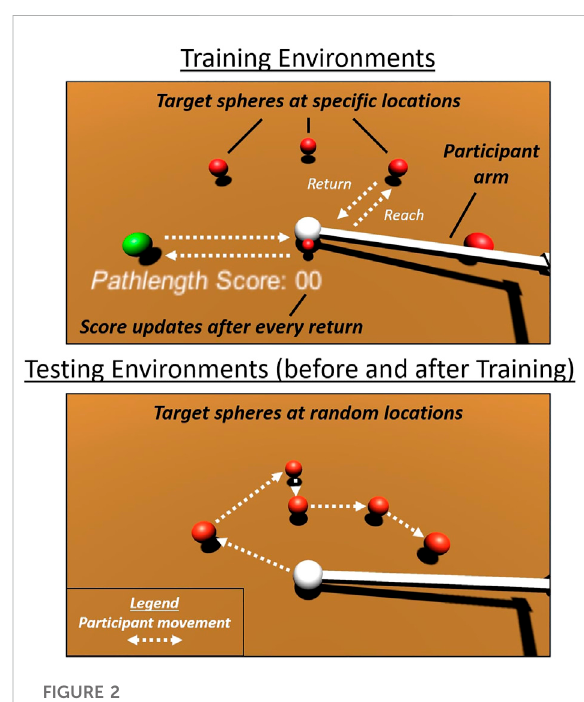
FIGURE 2 Three-dimensional virtual reality task environment shown for robot arm (white) under myoelectric control to make contact between its end-effector and target spheres. TOP) During point- to-point “ training ” , the targets were positioned equidistantly from a central initial position as the participant received augmented visual guidance in moving to (reach) and from (return) the targets. BOTTOM) During “ testing ” , augmented visual guidancewasremovedandtargetswererandomlypositioned,and participants pursued targets in series and in the sequence order they